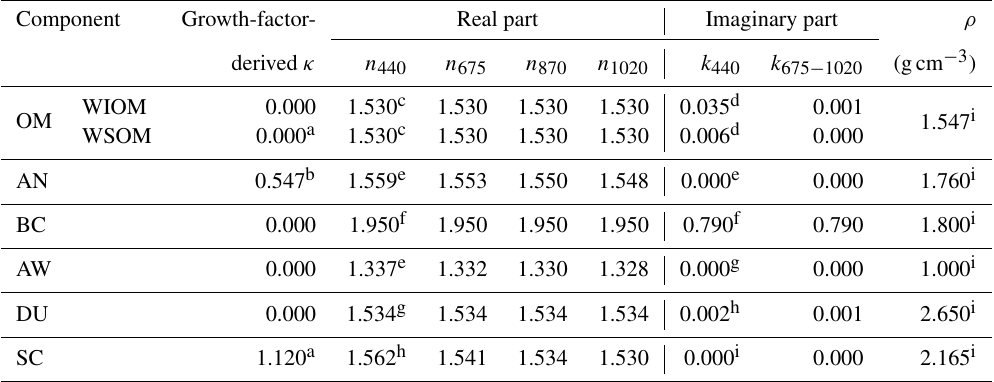
Table 2. Growth-factor-derived hygroscopicity parameter ( κ ), complex refractive indices ( m = n − ik ) at four wavelengths and effective density ( ρ ) of model components. Real and imaginary parts at four standard AERONET aerosol product wavelengths (440, 675, 870 and 1020nm) are